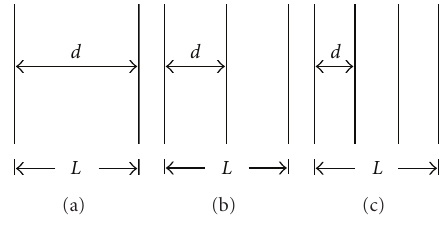
Figure 2: Configurations of the parallel